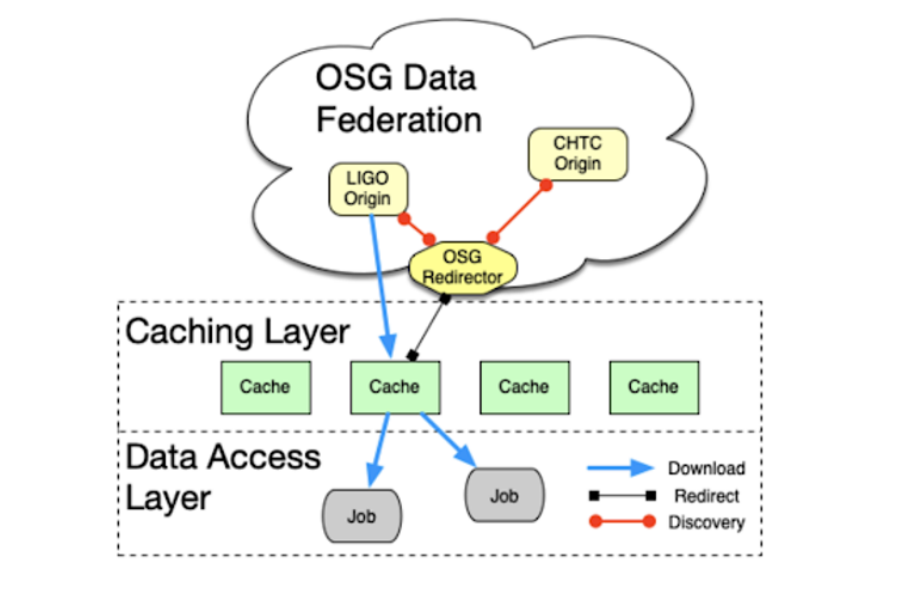
Figure 1. StashCache architecture for application performance in IGWN. Jobs running on the grid request data from the nearest Cache. Missing data on the caching later will be served directly by the Origin as the redirector - run by OSG Operations - discovers which Origin holds the